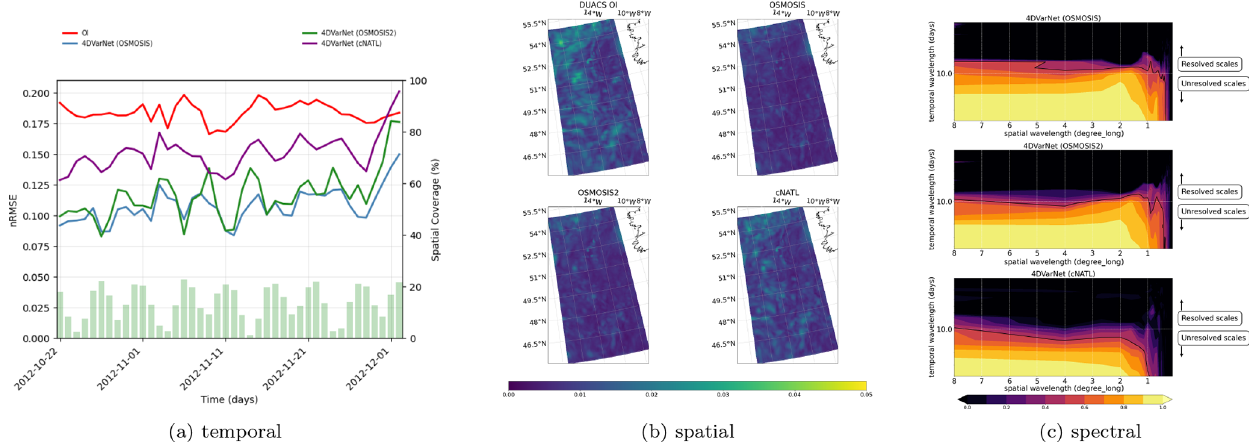
Figure B2. 4DVarNet generalization capabilities (OSMOSIS), with the spatial, temporal, and spectral performance on the BOOST-SWOT DC evaluation period, based on the three different training domains of OSMOSIS, OSMOSIS2, and cNATL.